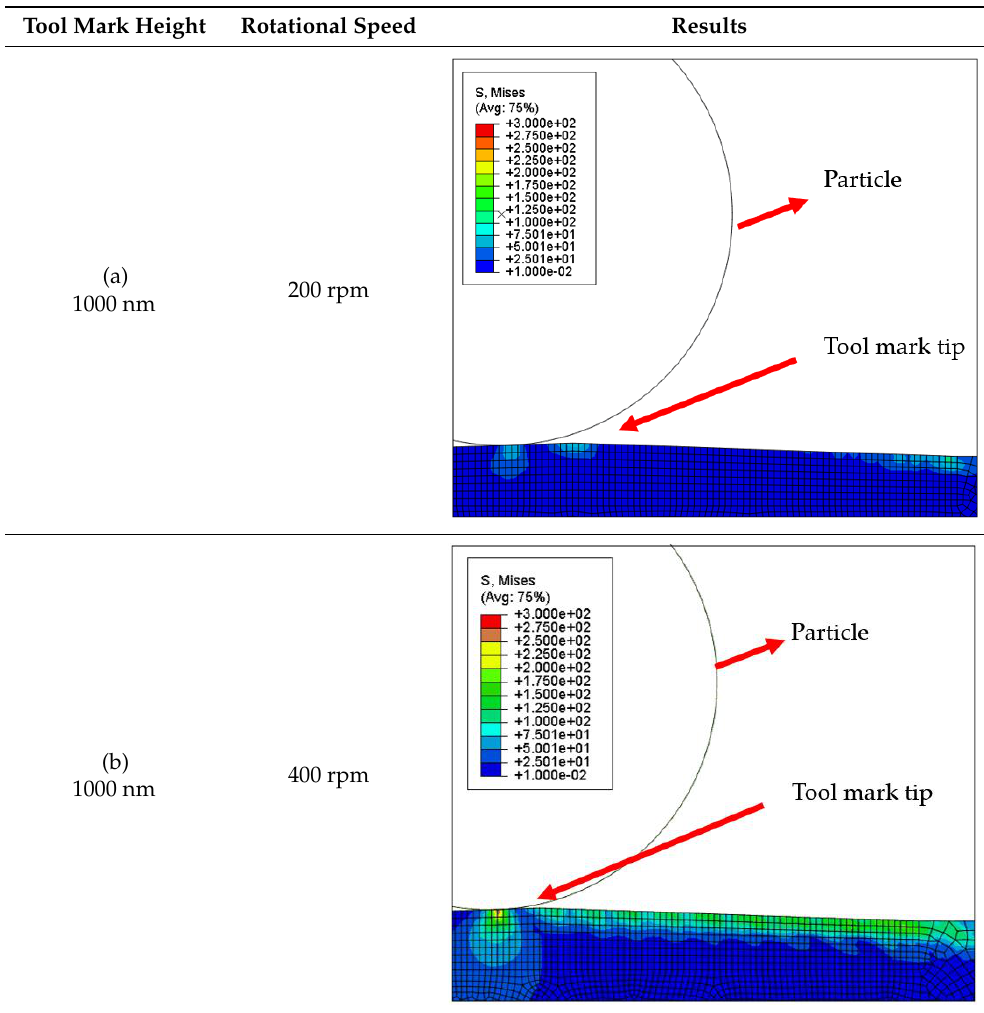
Table 4. The 1000 nm high tool mark workpiece surface under particle impact at different